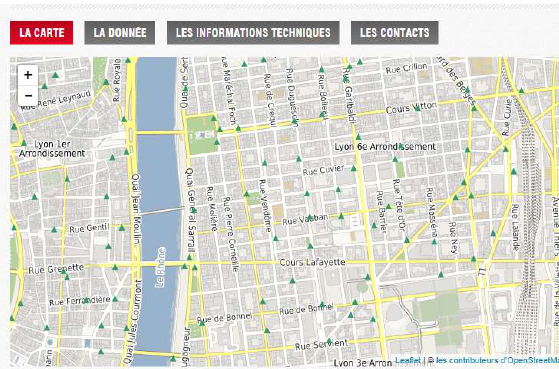
Figure 13. Map of the bottle banks on the data platform of the Metropolis.